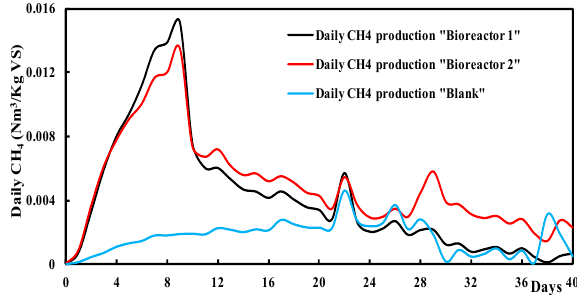
Figure 4. Daily bio-methane production of the bioreactors.